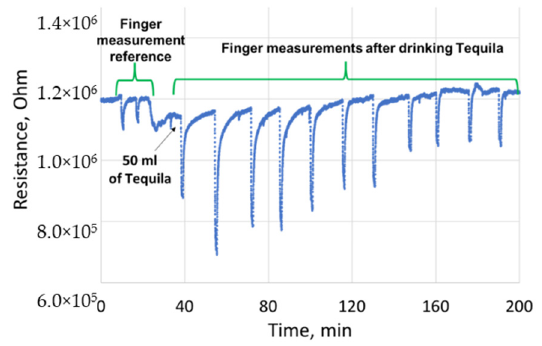
Figure 13 . The gas sensor transdermal measurements, separated by 15 min, during 1 min of exposure. Reprinted with permission from ref. [39]. Copyright 2019 IEEE.